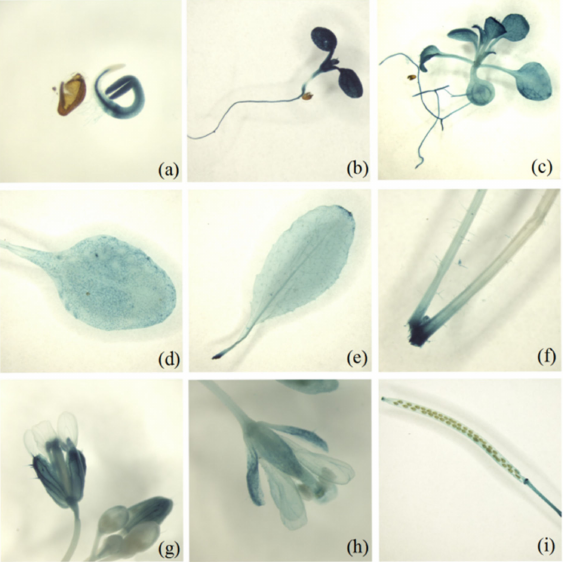
Figure 2. Histochemical localization of GUS activity in pMsD14-GUS transgenic Arabidopsis plants. ( a – i ) Seed that germinated for 72 h, 7-day, and 15-day-old seedlings; 25- and 35-day-old rosette leaf stem; inflorescence; flower; and seedpod for OsD14 as